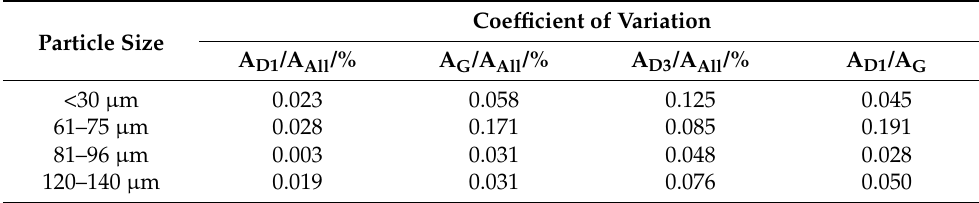
Table 4. Coefficient of variation in Raman characteristic parameters for different particle sizes of